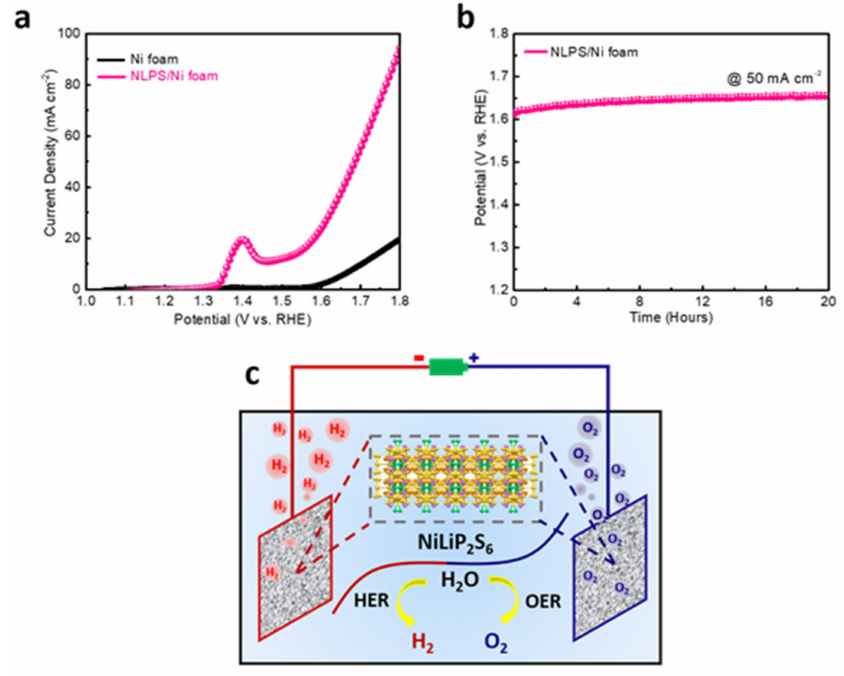
Figure 6. Overall water splitting in alkaline media. ( a ) Polarization LSV curves of NLPS/Ni foam and Ni foam; ( b ) durability test of NLPS/Ni foam at 50 mA cm − 2 ; ( c ) schematic illustration of NLPS/Ni foam electrode as both the anode and cathode the for overall water